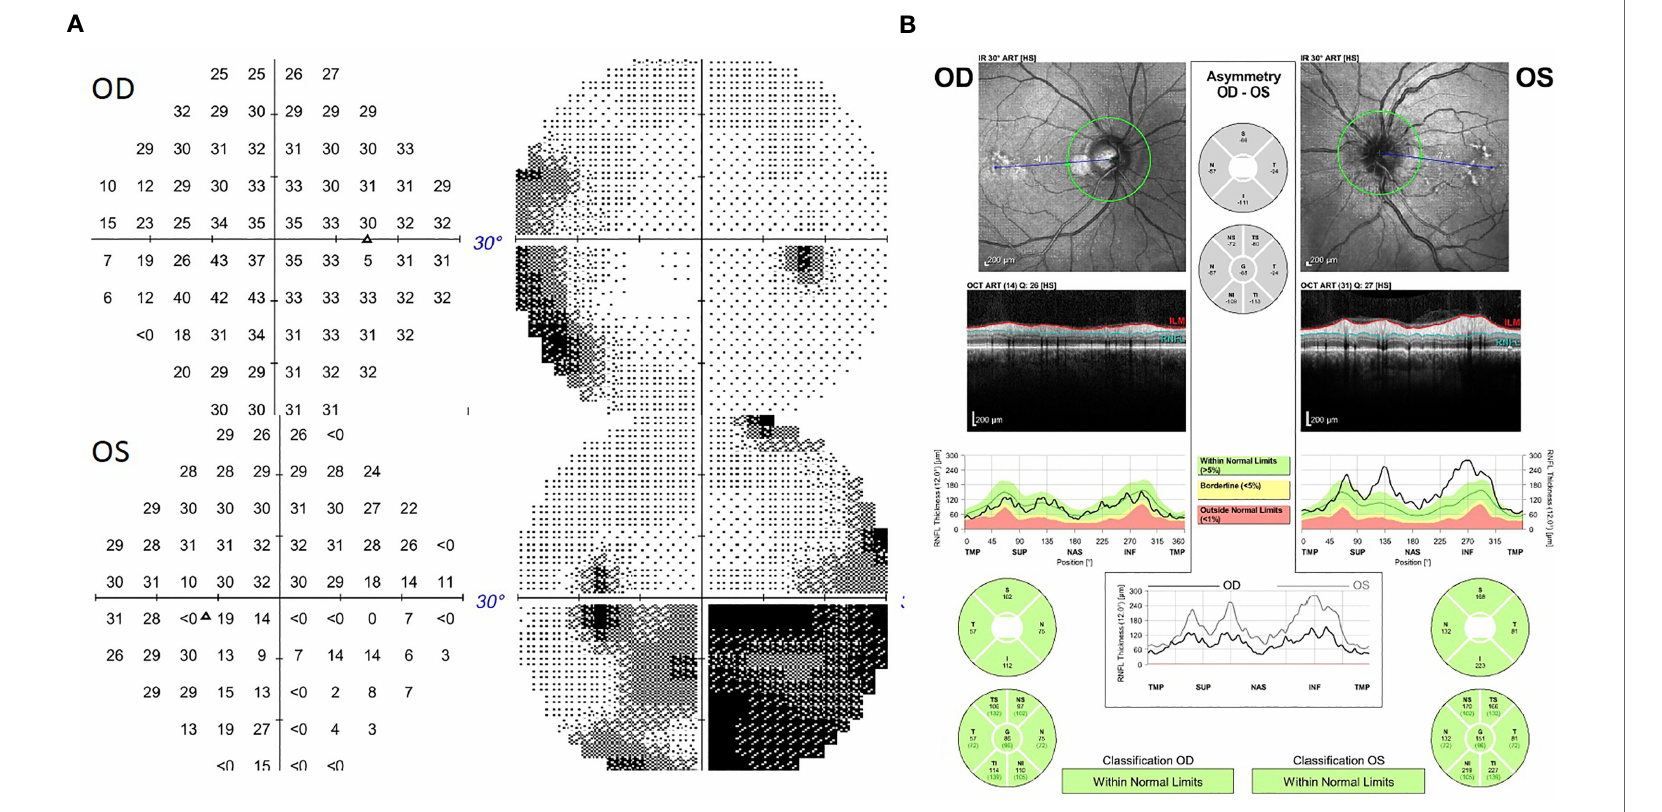
FIGURE 1 | (A) Humphrey Visual Field (HVF) 30-2 showing an inferior altitudinal defect in the left eye. (B) Optical coherence tomography (OCT) of the optic nerve showing increased thickness of the peripapillary retinal nerve fi ber layer in the left